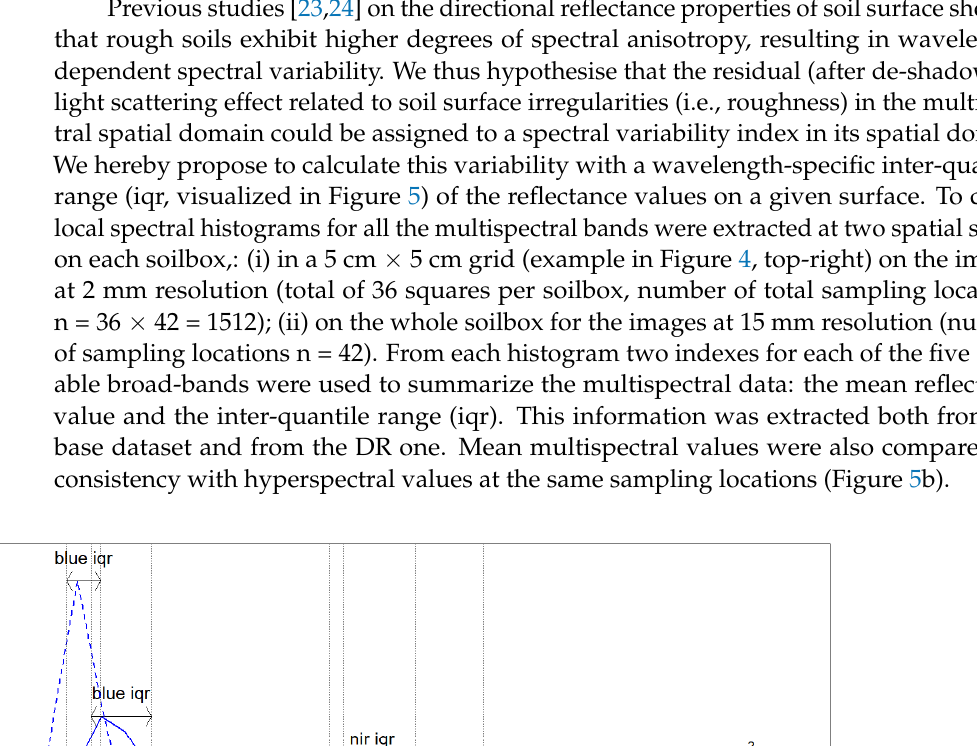
Figure 4. Example of RGB composite from multispectral image that shows the steps of pixel selection for the selective extraction of spectral data: original image; base dataset (with shadows removed) at 2 mm and 15 mm resampling; DR dataset (with roughness threshold < 2 mm) at 2 mm and 15 mm resampling. The images at 2 mm resolution also display with white lines the 6 × 6 grid used for partitioning reflectance histogram extraction.